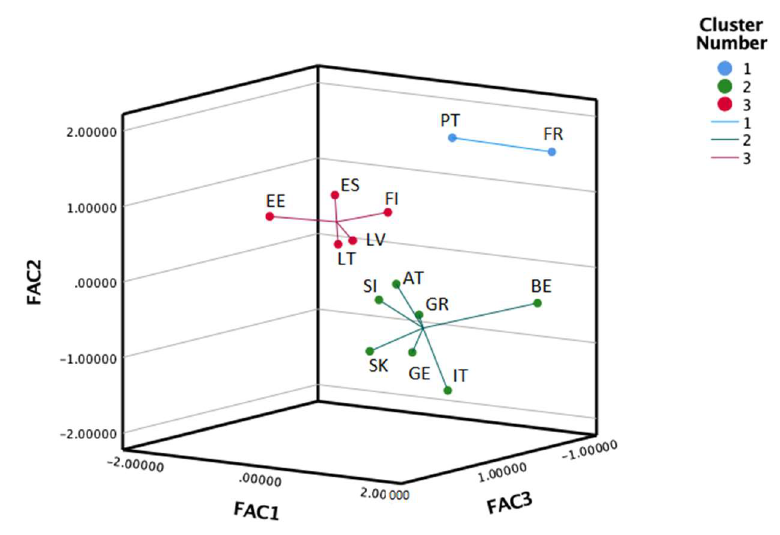
Figure 6. The “truncated” three-cluster case in 2019. Source Authors’ construction